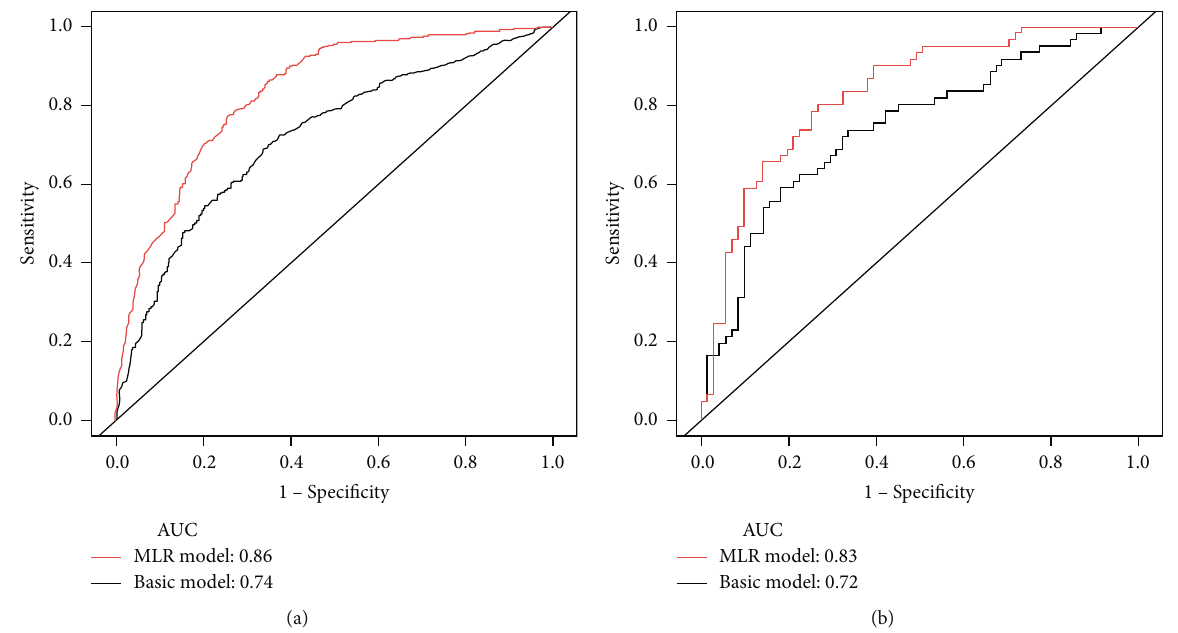
Figure 4: Receiver operating characteristic (ROC) curve analysis for a basic model (without MLR) and MLR model (with MLR). Black line represents the reduced model; red line represents the MLR model in the (a) development and (b) validation cohorts.